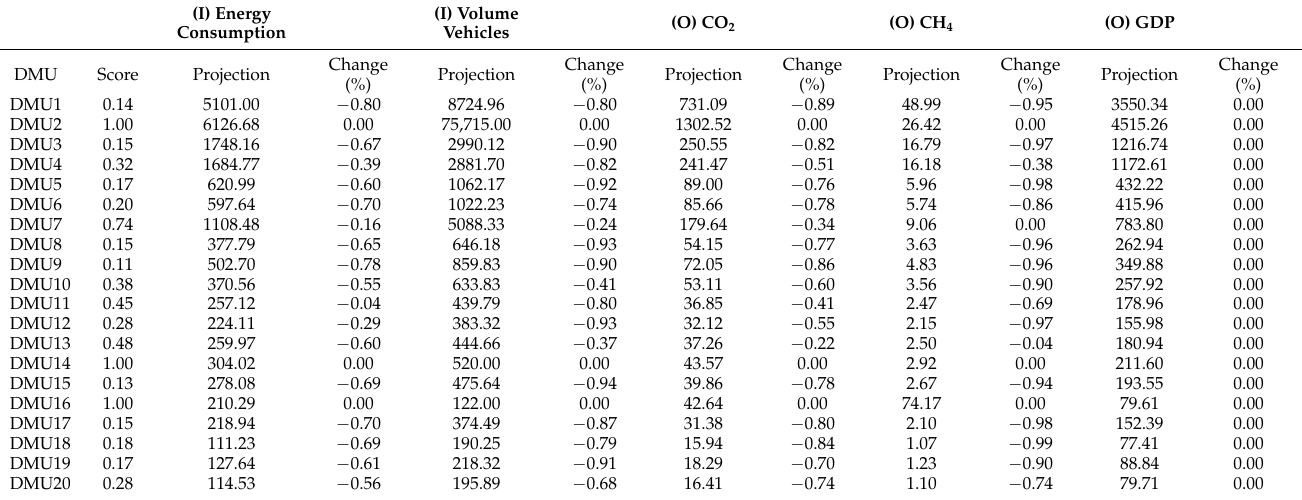
Table 8. Input/output factor projections. Source: authors’